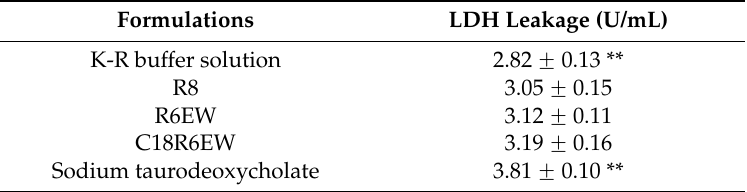
Table 2. Lactate dehydrogenase leakage in the intestinal lumen following pretreatment with various formulations (mean ± SD, N = 3).